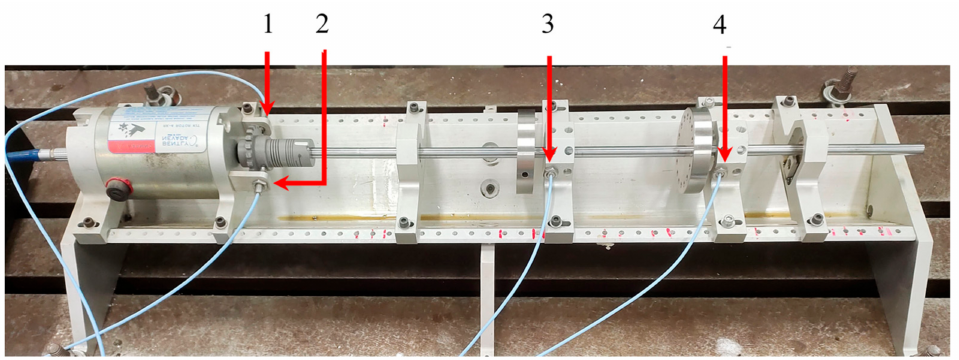
Figure 11. Dual-disk rotor experimental platform.